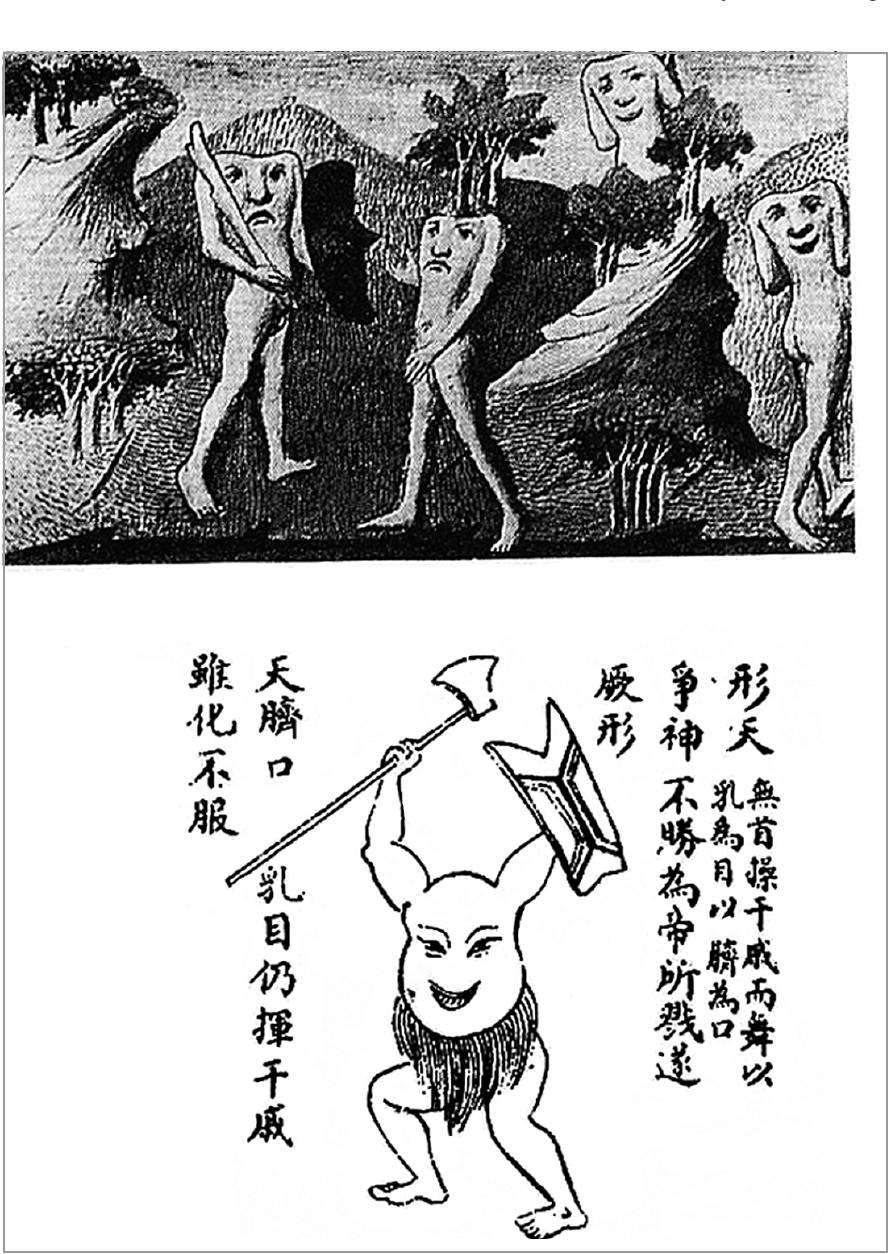
Figure 2 European idea of the Chinese in medieval time; below Chinese idea of the Europeans.